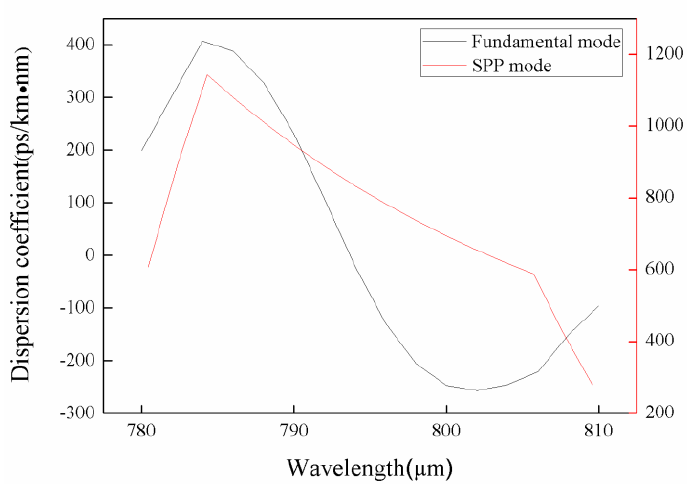
Figure 3. Dispersion coefficients for the fundamental mode and SPP mode. Conditions: r a = 0.6 µ m, r b = 0.3 µ m, r g = 0.2 µ m, and n = 1.34.